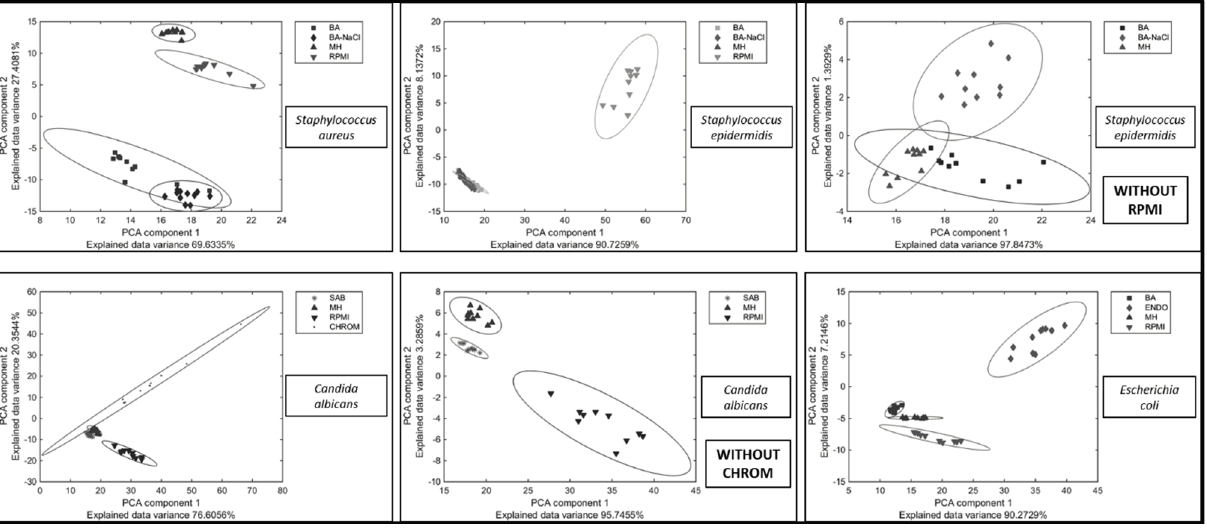
Figure 2. Repeatability of Raman spectra of the given organism after growth on different culture media (ENDO—Endo agar, BA—blood agar; BA-NaCl—blood agar with 10% NaCl;